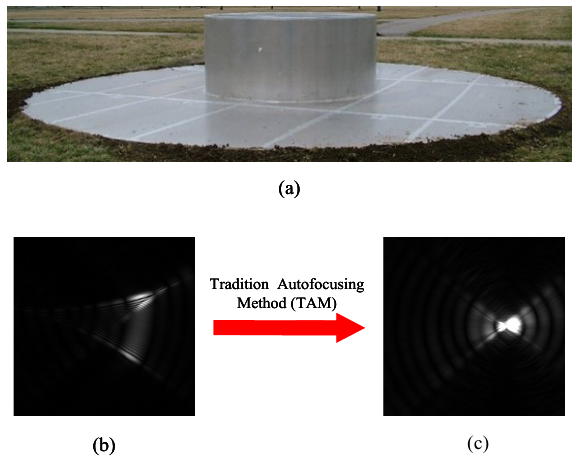
Figure 1. Optical and SAR images of a metal top hat: ( a ) the optical image of the metal top hat; ( b ) the SAR image of the top hat under the influence of motion error; ( c ) the defocused SAR images after applying the